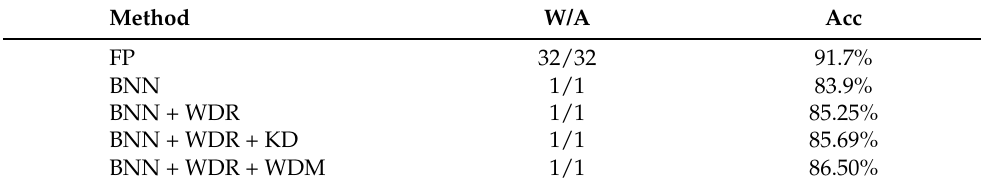
Table 3. Ablation Study—Exploration of BD-BNN. WDR and WDM stand for weight distribution regularization and weight distribution mimicking, respectively.